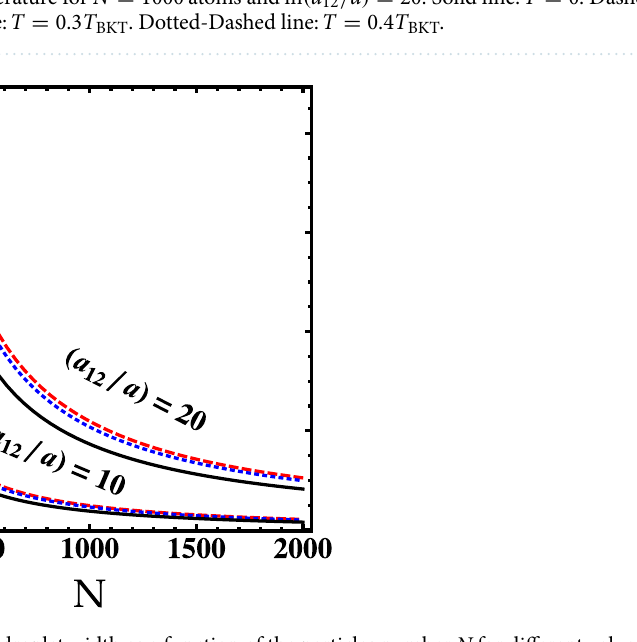
Figure 6. The self-bound droplet width as a function of the particles number N for different values of ln ( a 12 / a ) . The solid line corresponds to our generalized GPE (15). The red dashed line corresponds to the standard GPE 13 . The blue dotted line corresponds to the variational